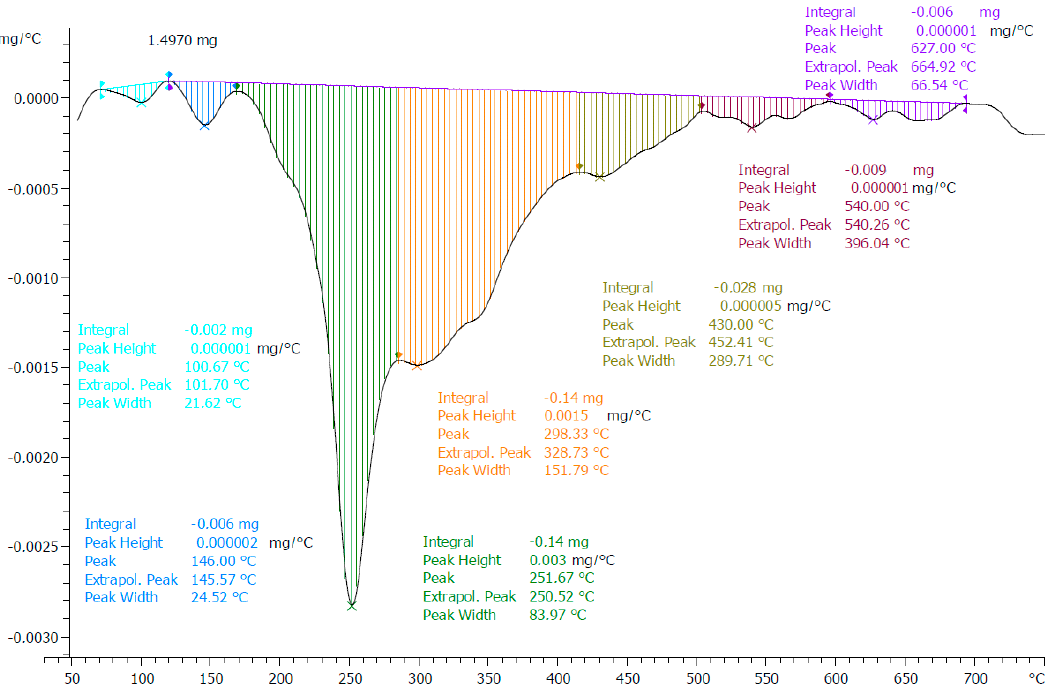
Figure A6. AuNP-RGD-NIR-dye 8 with mass loss of ~22.17%. The NIR-dye-ligands accounts for 0.46% mass loss.